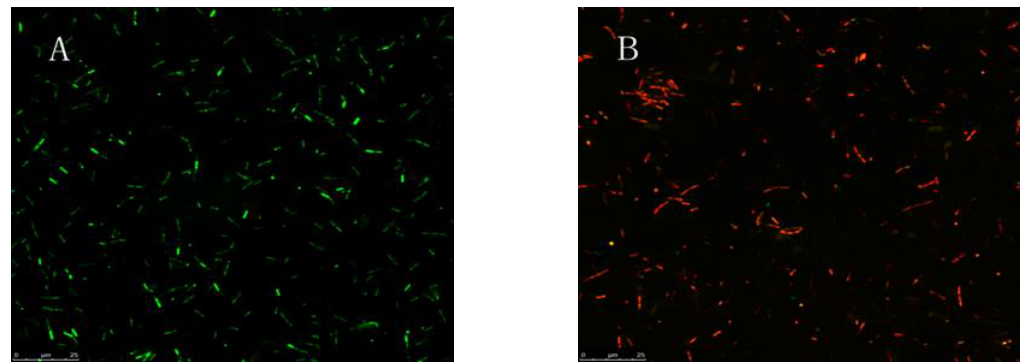
Figure 2. Fluorescent microscopy (FM) images of E. coli. ( A ) Control E. coli ; ( B ) Plasma-treated E. coli.